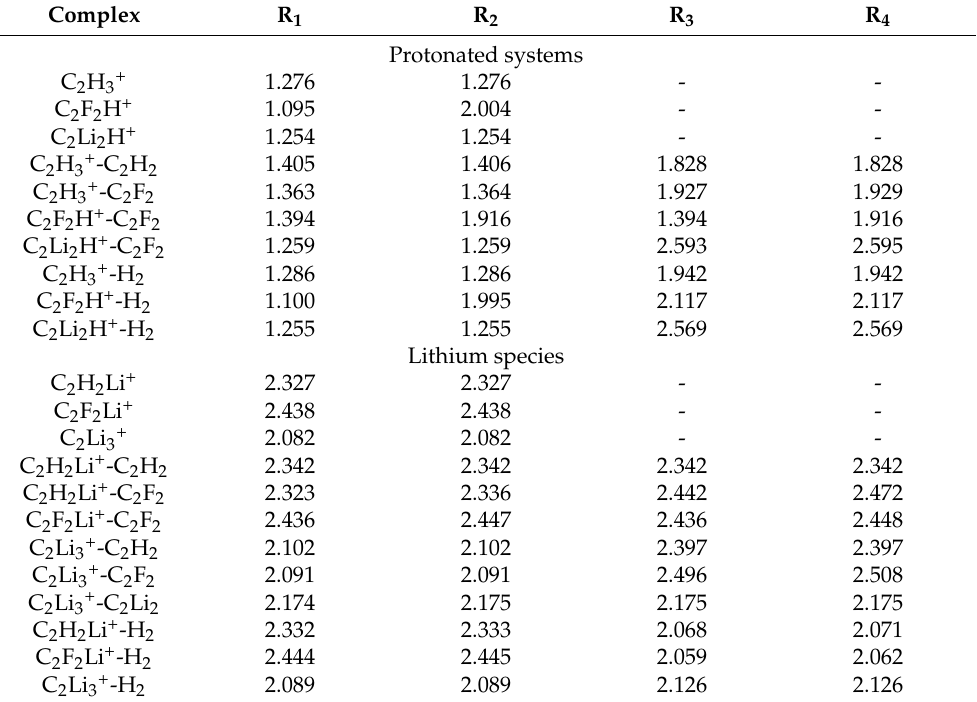
Table 1. Distances between the proton or lithium center and neighbouring carbon atoms for π - electron species and neighbouring hydrogen atoms for dihydrogen complexes (in Å); see Scheme 1, where distances are defined. If the cation is inserted between π -electron systems, R 1 and R 2 distances usually correspond to shorter contacts. For the dihydrogen complexes, R 3 and R 4 correspond to H/Li ··· H distances. Complex R